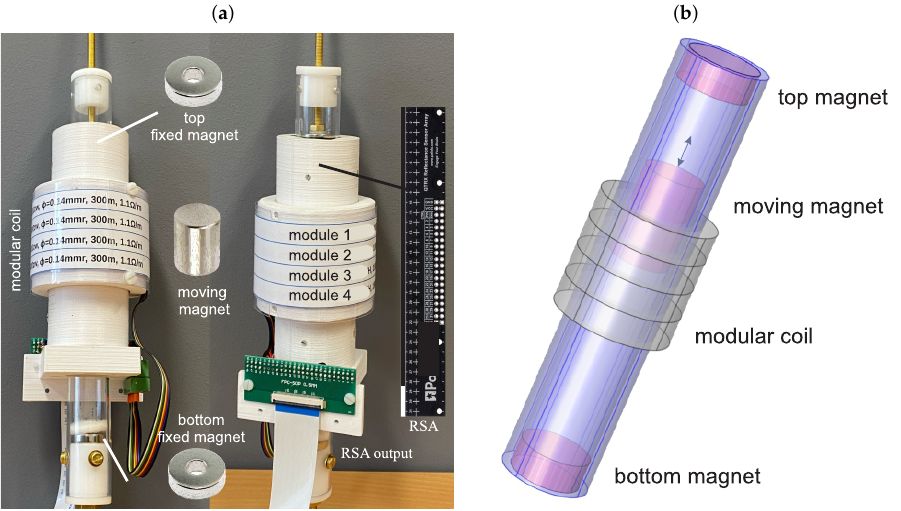
Figure 1. Photo ( a ) and scheme ( b ) of the prototype electromagnetic harvester with a modular coil. Each segment of the modular coil can be activated independently.